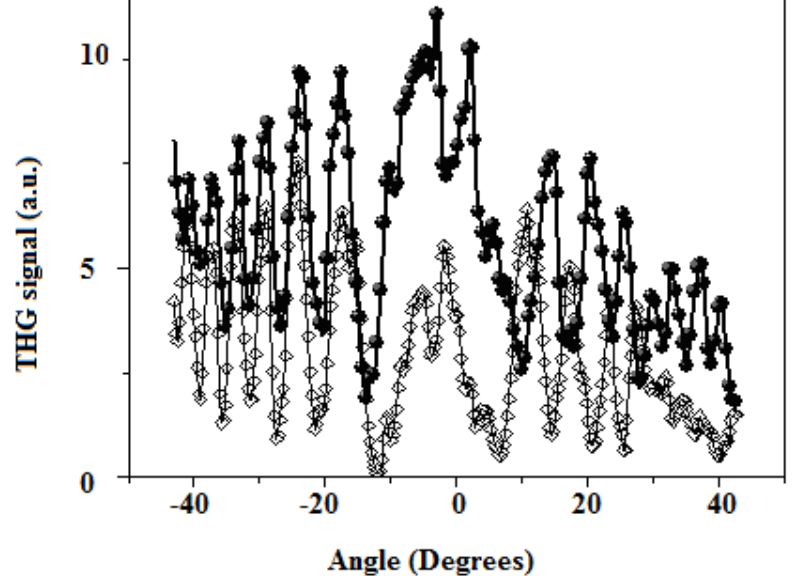
Figure 4. THG Maker-fringe pattern for 174 nm-thin polymer film doped with 50 wt. % of compound 13 (filled circles) and for a 1-mm-thick substrate without a film deposited on it (open diamonds); lines are guides for the eye. The fundamental wavelength was 1260 nm.